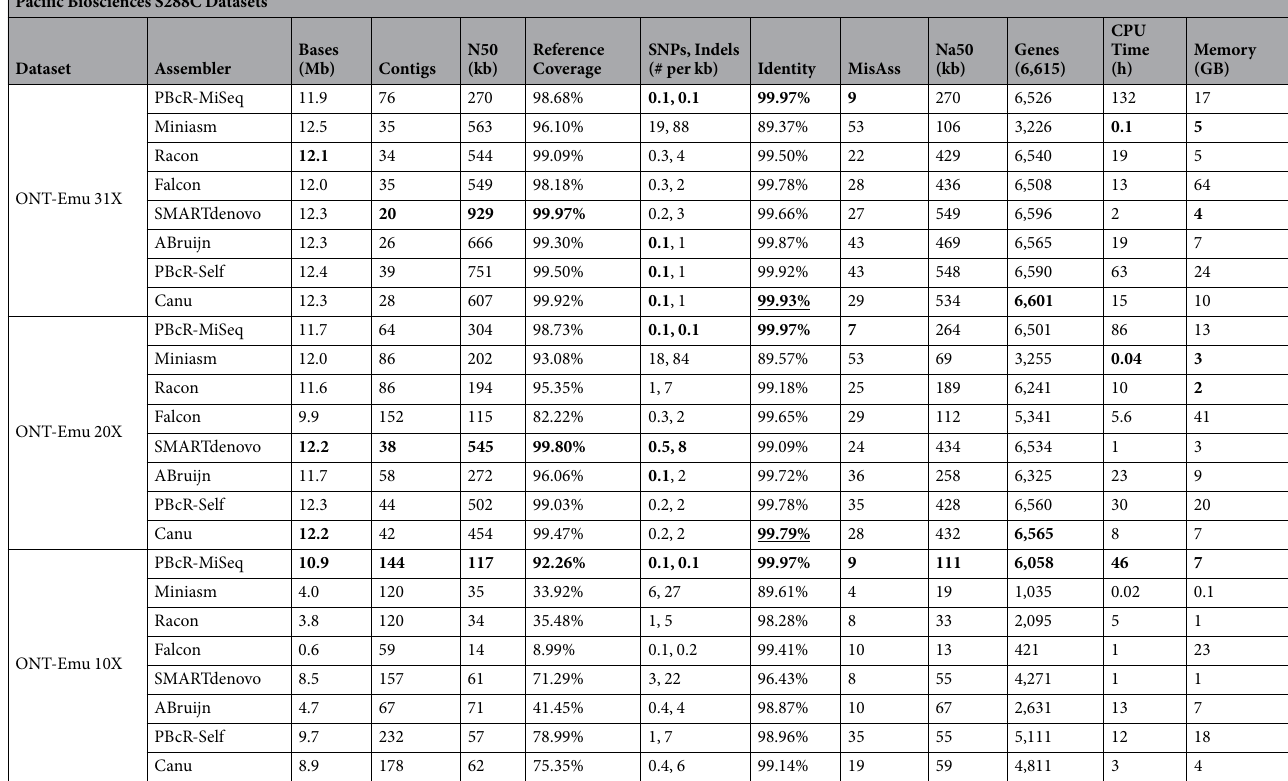
Table 4. As Table 3 but for PacBio-based assemblies from the ONT-Emu PacBio subsets at, from top to bottom, 31X, 20X and 10X depth.